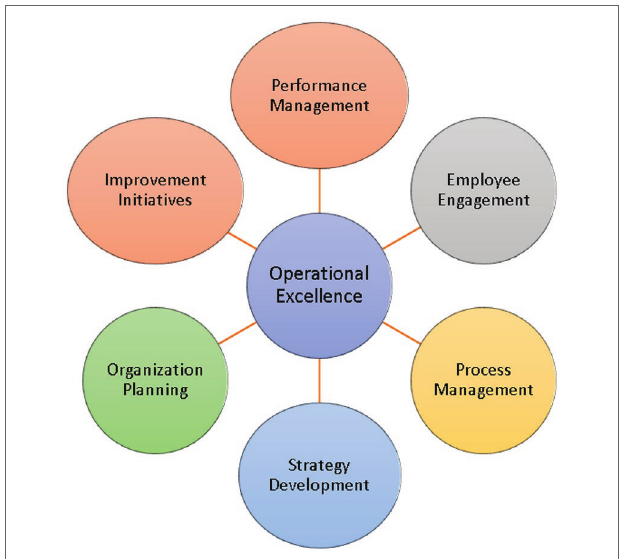
FIGURE 1 | Operational excellence core